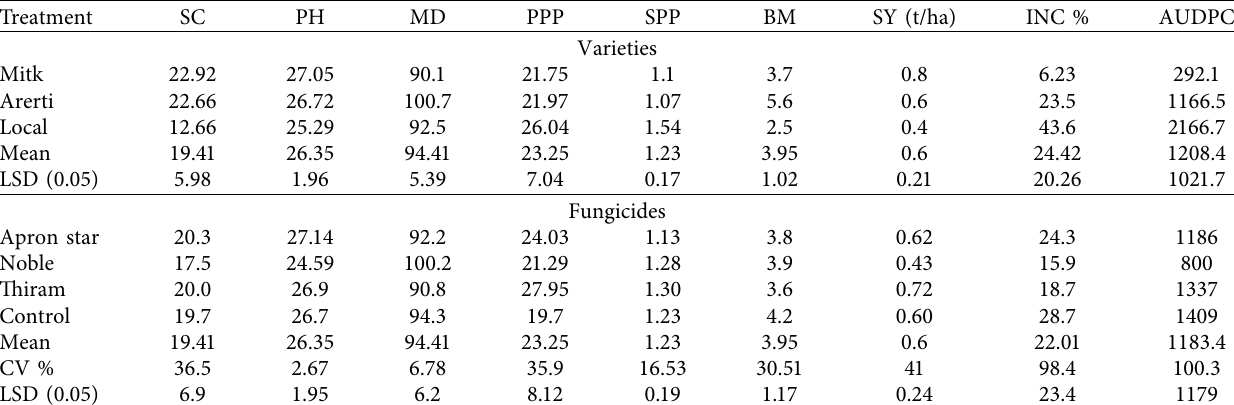
Table 3: Effect of seed-dressing fungicides and chickpea varieties on seed yield, growth parameters, and on fusarium wilt disease epidemics at Lalibella